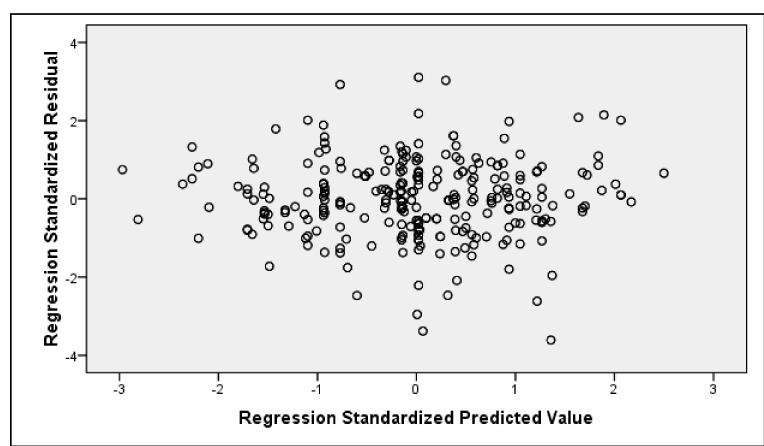
Figure A1. Normal P-P plot of regression standardized residual